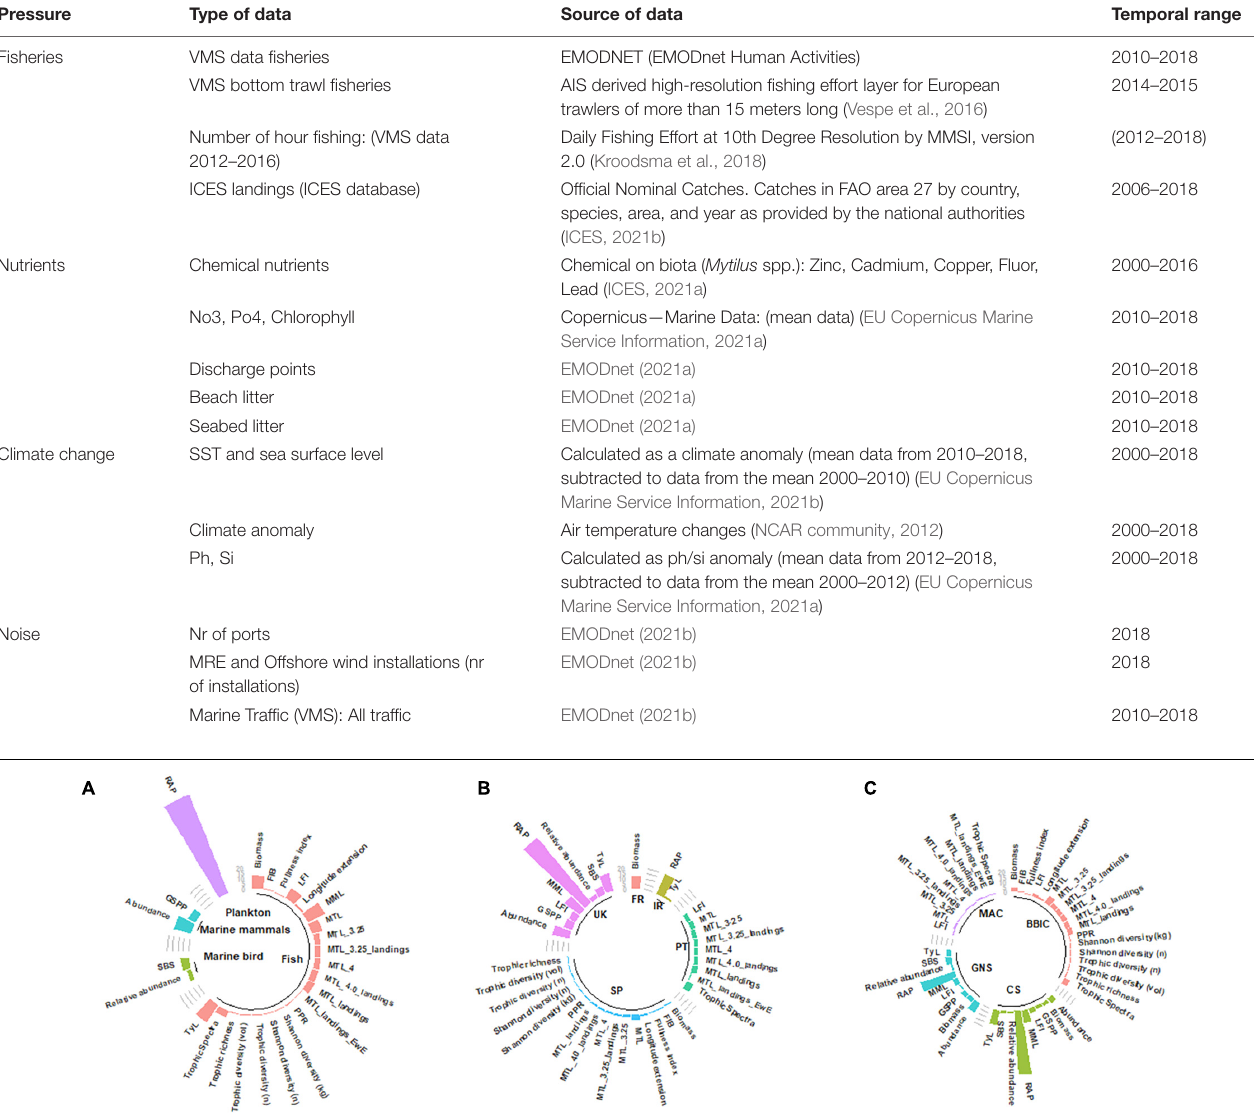
TABLE 2 | Anthropogenic data retrieved for the study: type of pressure, data, source, and temporal scale of the dataset. Pressure